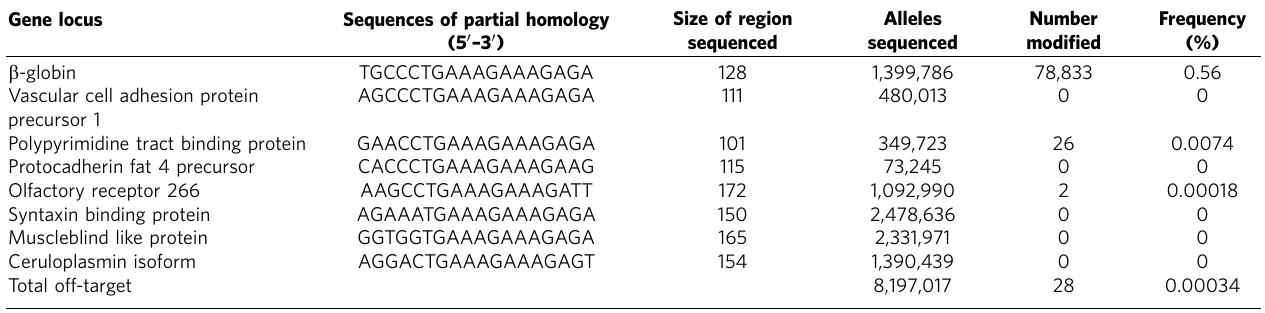
Table 1 | Off-target effects in bone marrow cells following intravenous treatment of b -globin/GFP mice with g tcPNA4/donor DNA